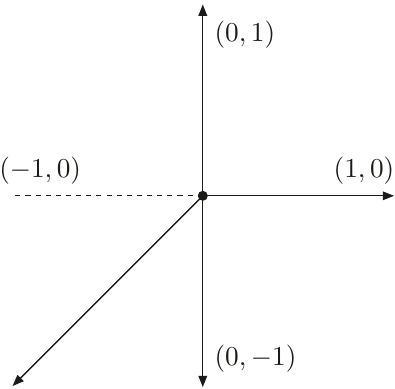
Figure 2 . A toric fan for dP 1 can be obtained by removing the edge ( − 1 , 0) from the toric fan for dP 2